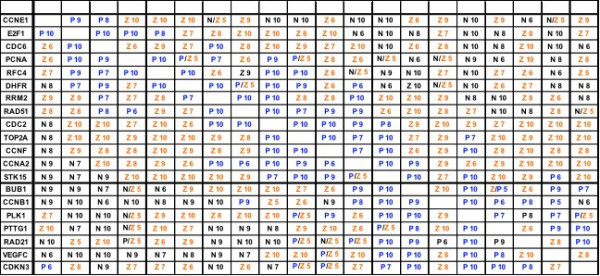
Rules obtained from the TT3 data set for genes listed in Table 2. Outputs are in columns in the same sequence as the labeled inputs in rows. The majority of rules (zero, positive or negative based on the rule definitions in Table 1) are given (Z, P, and N respectively) along with the number of rule sets (out of 10) with that rule. In the case of a tie, 5 each, both are given in the appropriate cell.